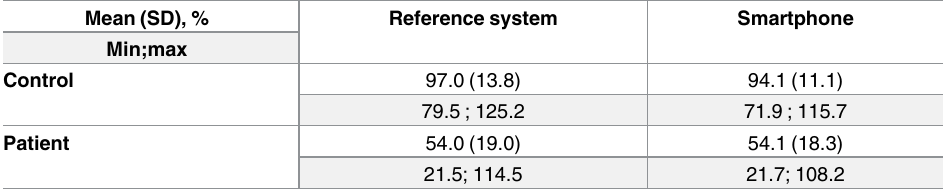
Table 2. Mean and standard deviation of B-B Score using the smartphone and the reference system. Unit of scores are % representingthe performanceof the pathologicalside comparedto the healthyside.